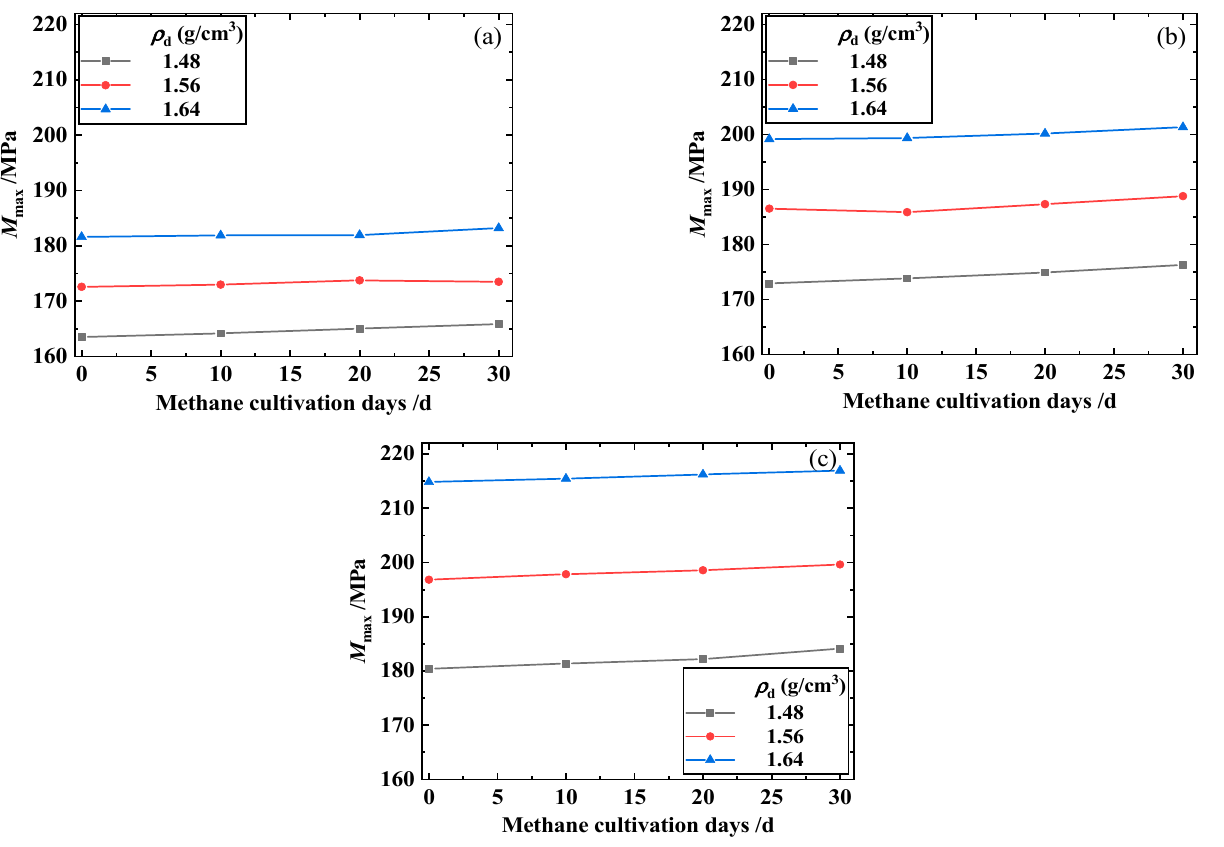
Figure 12. Relationship between M max and methane cultivation days of the biochar–methanotroph– clay mixture, under different biochar contents: ( a ) α = 0%; ( b ) α = 10%; ( c ) α = 15%.